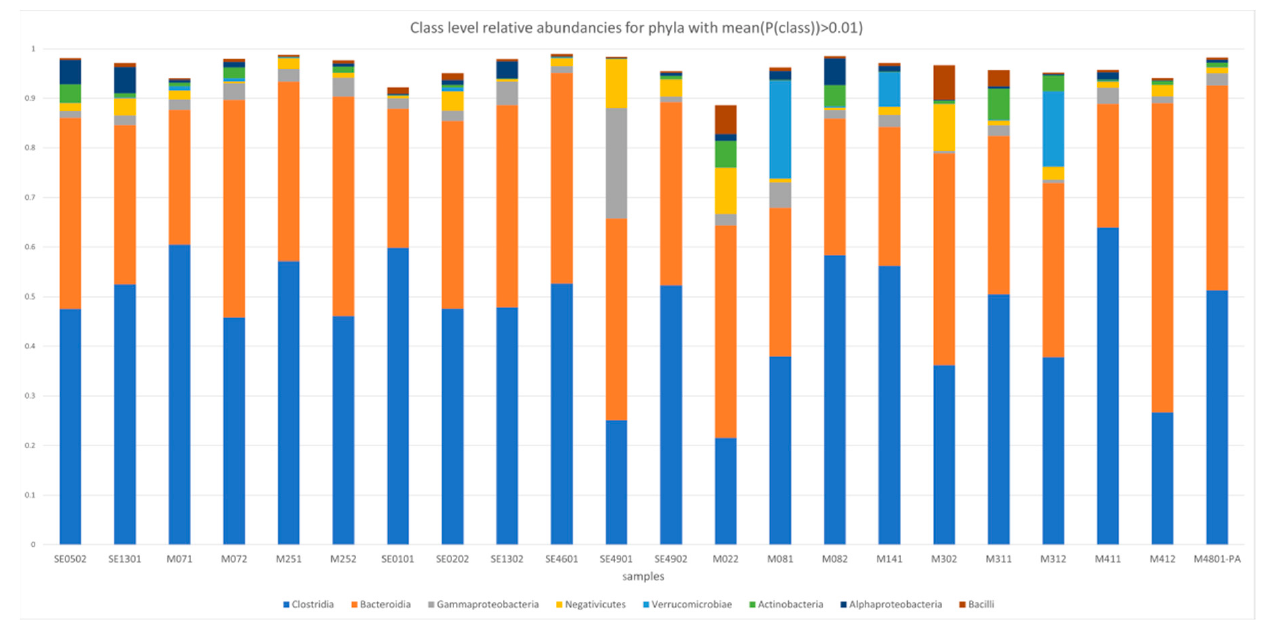
Figure 14. The relative abundances of bacteria at the class level between the two groups. The first 6 columns are the subjects of the OSA − atherosclerosis group, and the next 16 columns are the subjects of the OSA + atherosclerosis group.